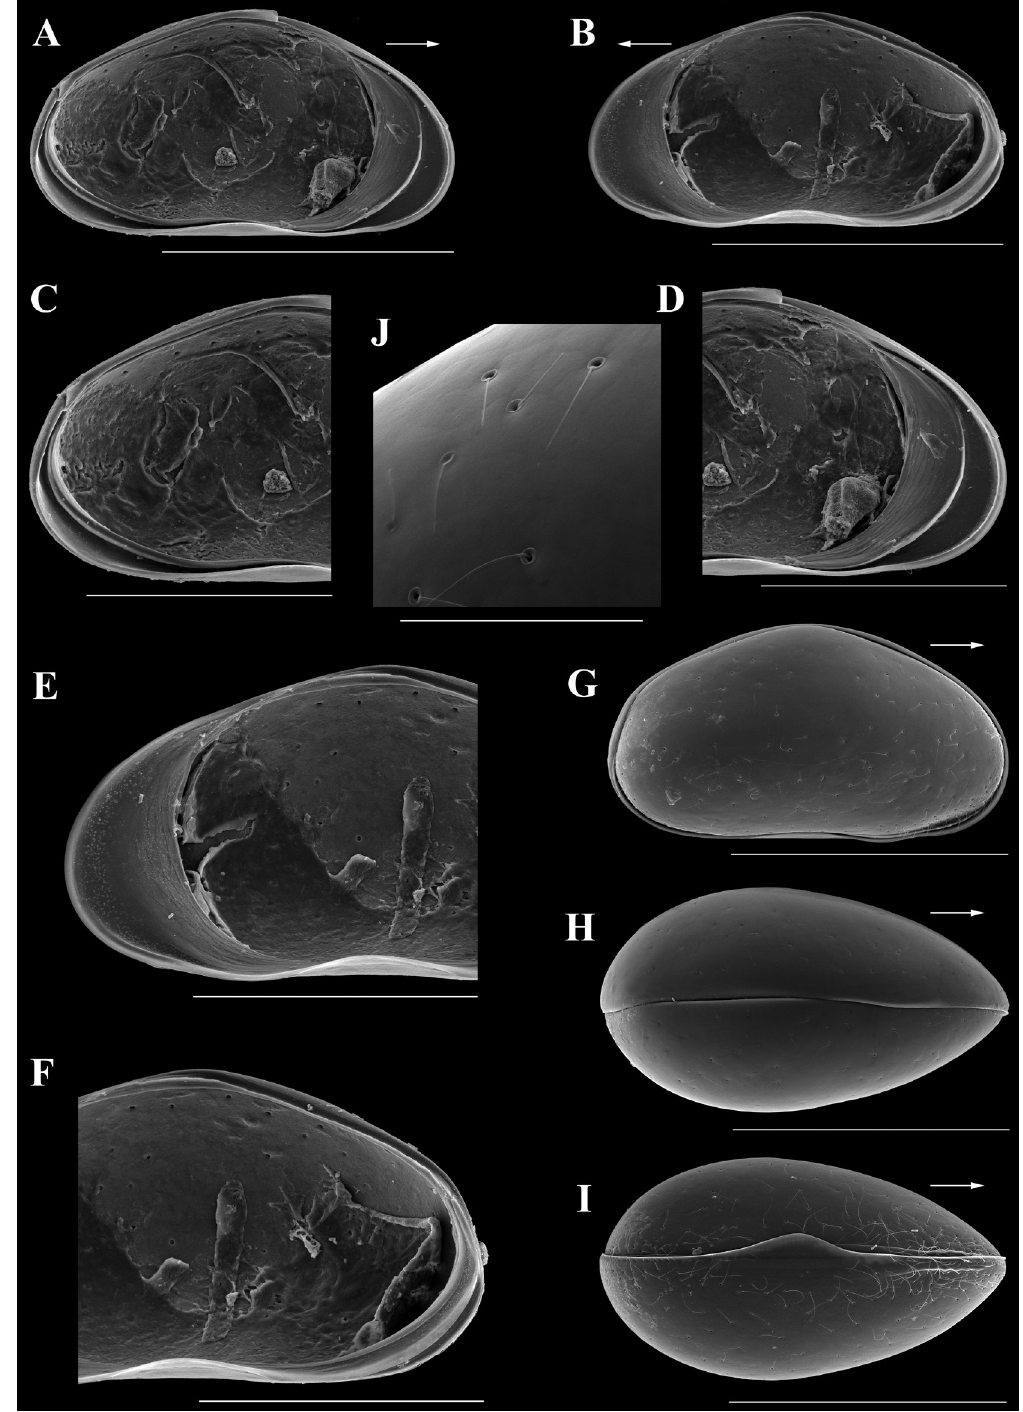
Fig. 11. Brasilodopsis baiabonita gen. et sp. nov. from Araguaia River floodplain, ♀. A . LVi (MZUSP 41844). B . RVi (MZUSP 41844). C . LVi, detail of posterior part (MZUSP 41844). D . LVi, detail of anterior part (MZUSP 41844). E . RVi, detail of anterior part (MZUSP 41844). F . RVi, detail of posterior part (MZUSP 41844). G . CpRl (MZUSP 41845). H . CpD (MZUSP 41846). I . CpV (MZUSP 41847). J . CpD, detail of Cp surface (MZUSP 41846). Scale bars: A–B, G–I = 300 µm; C–F = 200 µm; J = 50